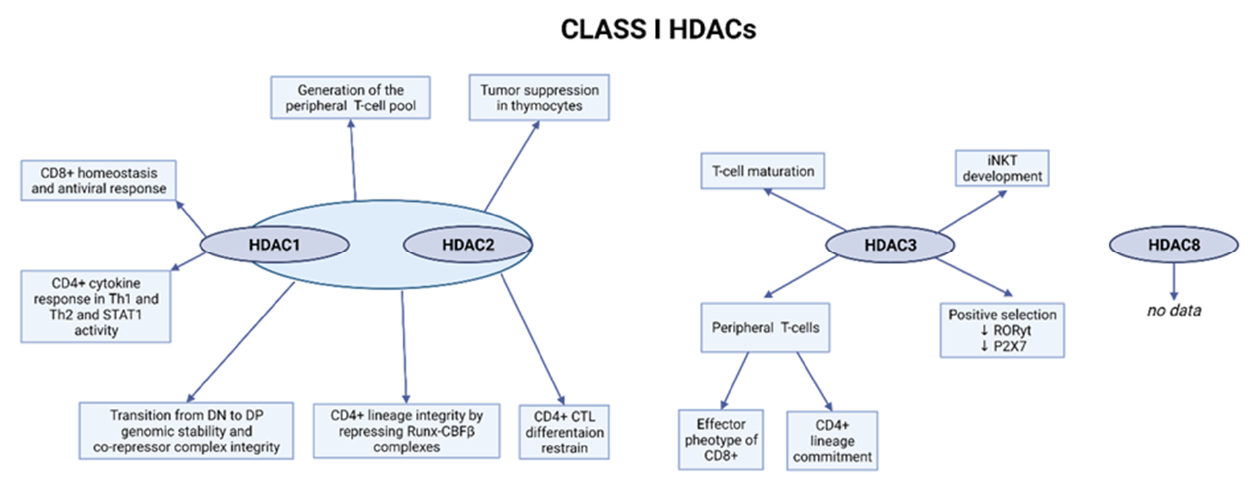
Figure 1. Role of class I HDACs in T-cells. Created with BioRender.